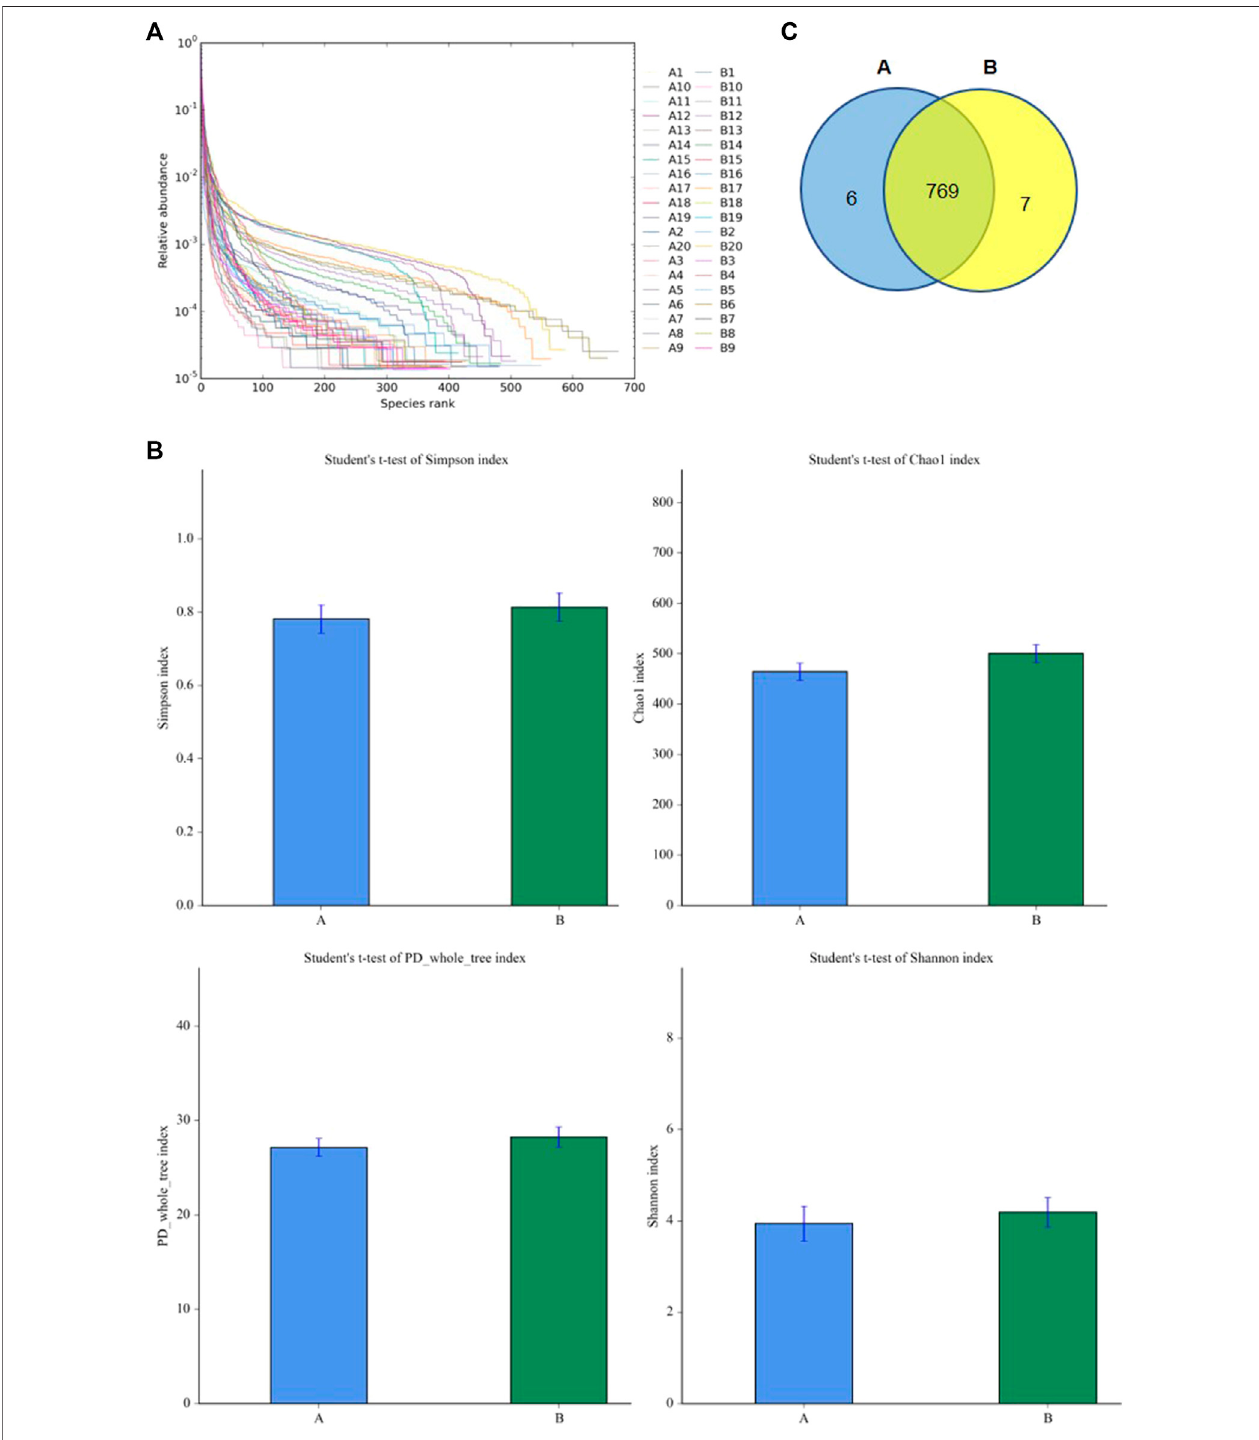
FIGURE 2 | Diversities offecal microbiome. (A) The rank abundance curve. (B) The changes of Chao 1 index. (C) Venn diagram. A: SAE group; B: nonSAE group.